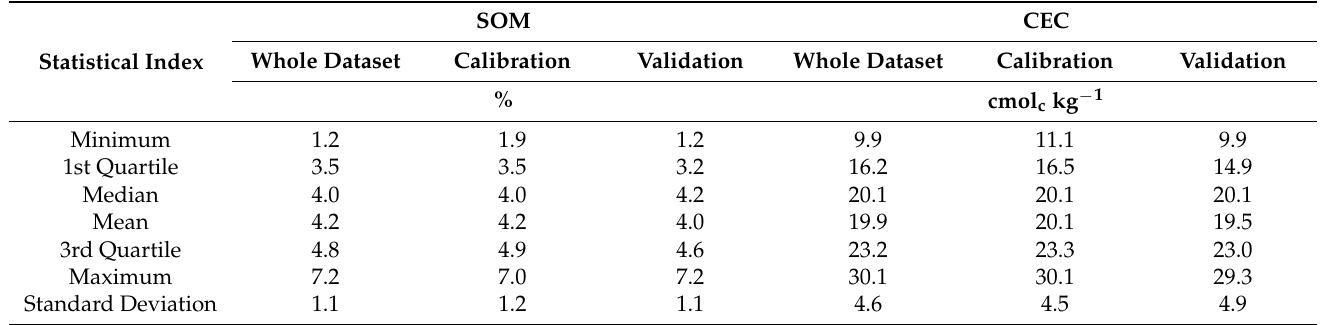
Table 2. Summary statistics of soil organic matter content (SOM) and cation exchange capacity (CEC) data for the study area.